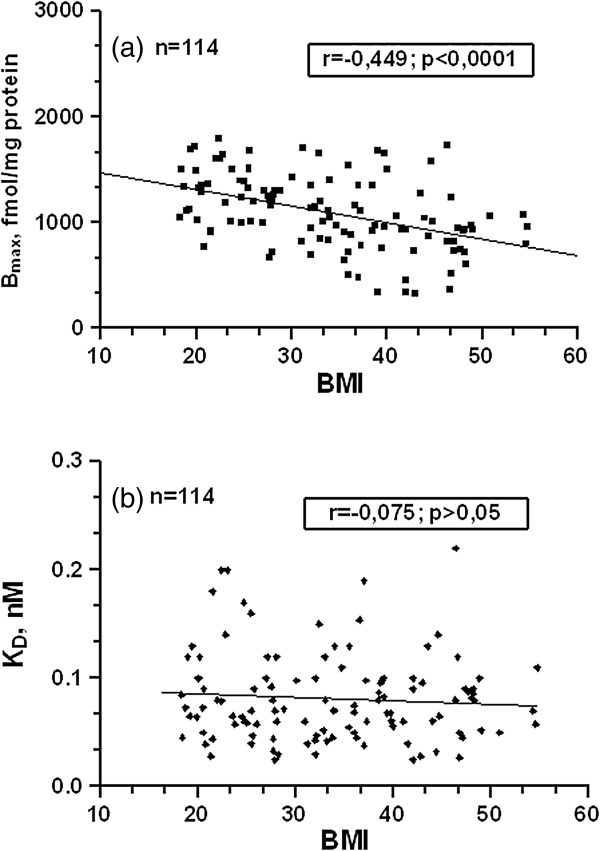
Correlations of platelet SERT parameters with subjects’ BMI (Kg/m2). Correlations between a) [3H]-paroxetine Bmax (fmol/mg protein), b) [3H]-paroxetine KD (nM) and BMI. Panels inside figures report the corresponding Pearson r coefficient and its statistical significance. Lines in a) and b) represents data linear fit from linear regression analysis.